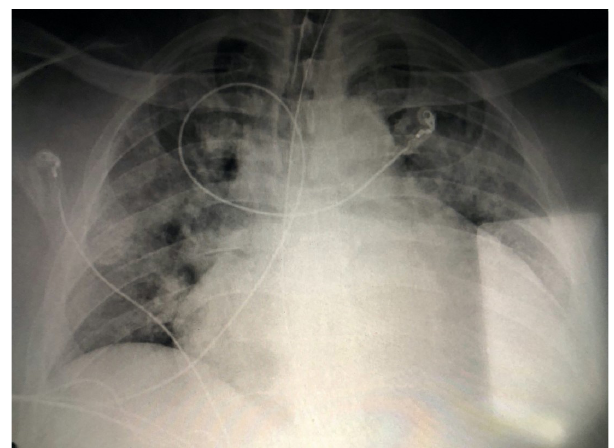
Image 1. Anterior-posterior chest radiograph of a 48-year-old male with respiratory distress and altered mental